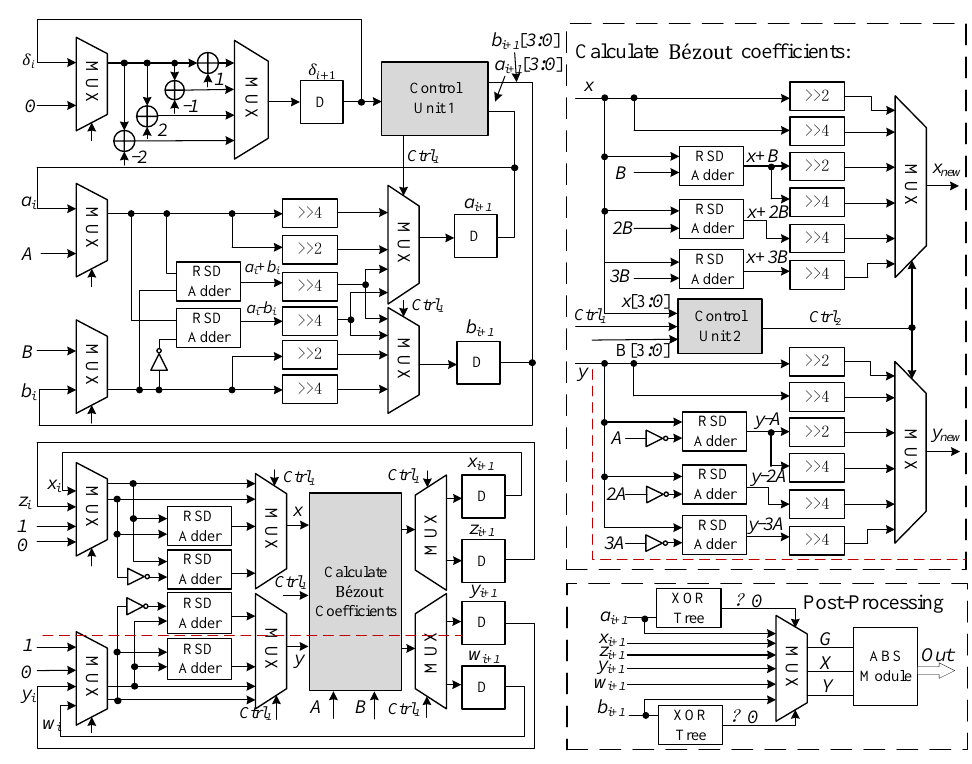
Figure 6: The architecture for the two-bit PM